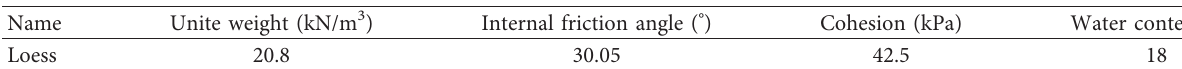
Figure 14: FV-U1 curves. Table 3: Parameters of soil.